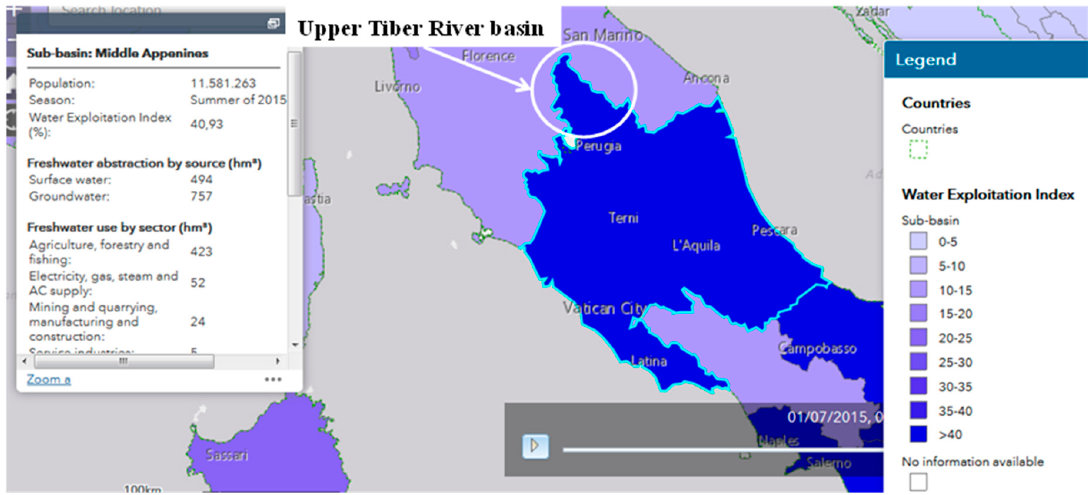
Figure 12. European Environment Agency, WEI + value in summer 2015 for the Middle Appenines District (published 10 October 2018, last modified 28 November 2019).